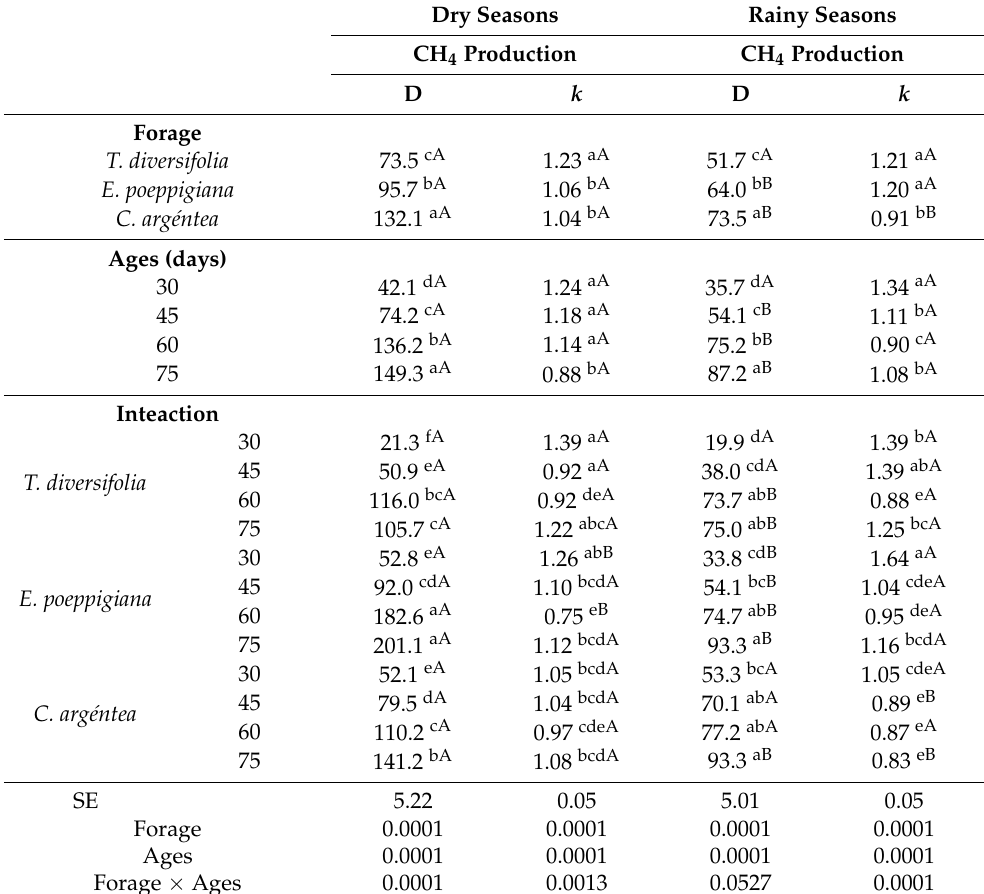
Table 2. CH 4 production parameters (mLCH 4 /0.400 g incubated DM) of shrub and tree species at different cutting ages, in the dry and rainy